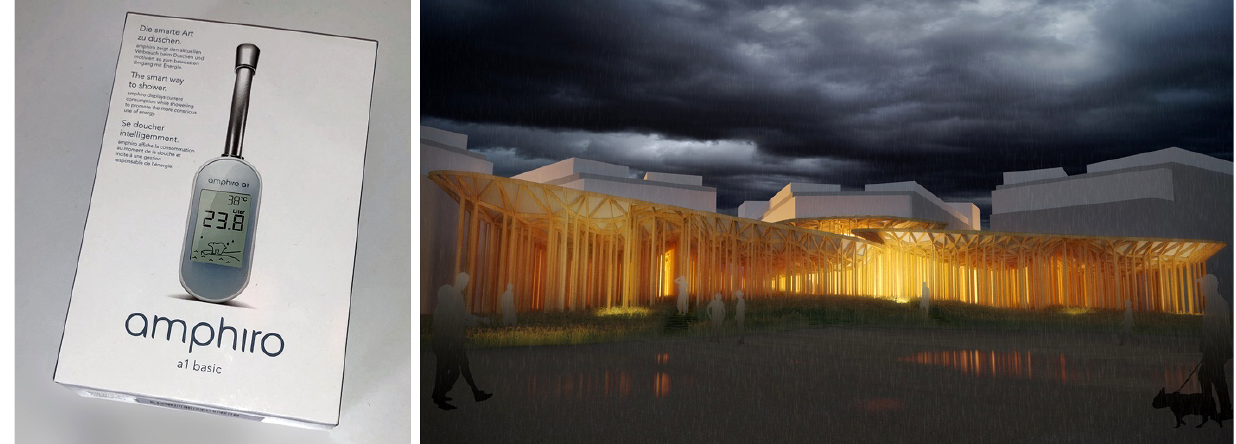
Figure 3a. A ‘smart’ shower application ready for an informed user. Image credits: Loove Broms. 3b. A communal bathing facility. Image credits: Patrik